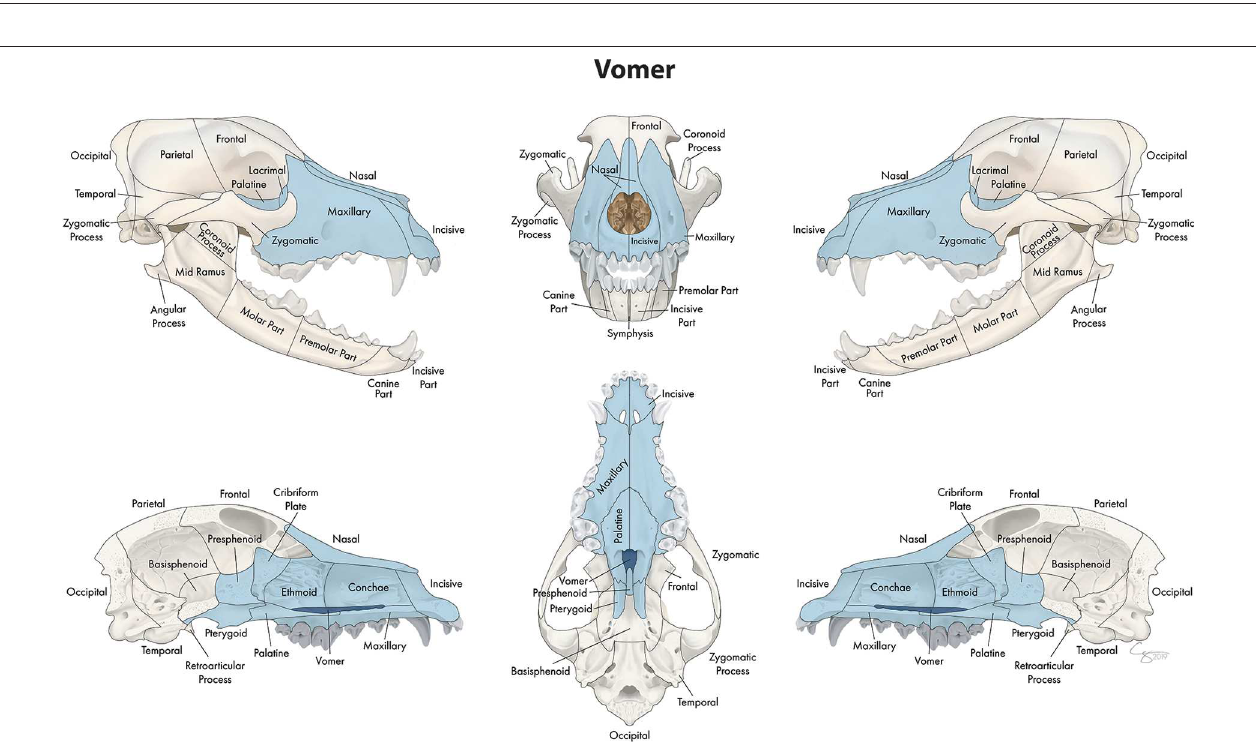
FIGURE 5 | Significant bones or regions fractured concurrently with the vomer. When the vomer was the region of interest, the conchae, cribriform plate, ethmoid, presphenoid, and bilateral incisive, maxillary, nasal, lacrimal, palatine, and pterygoid bones fractured concurrently.